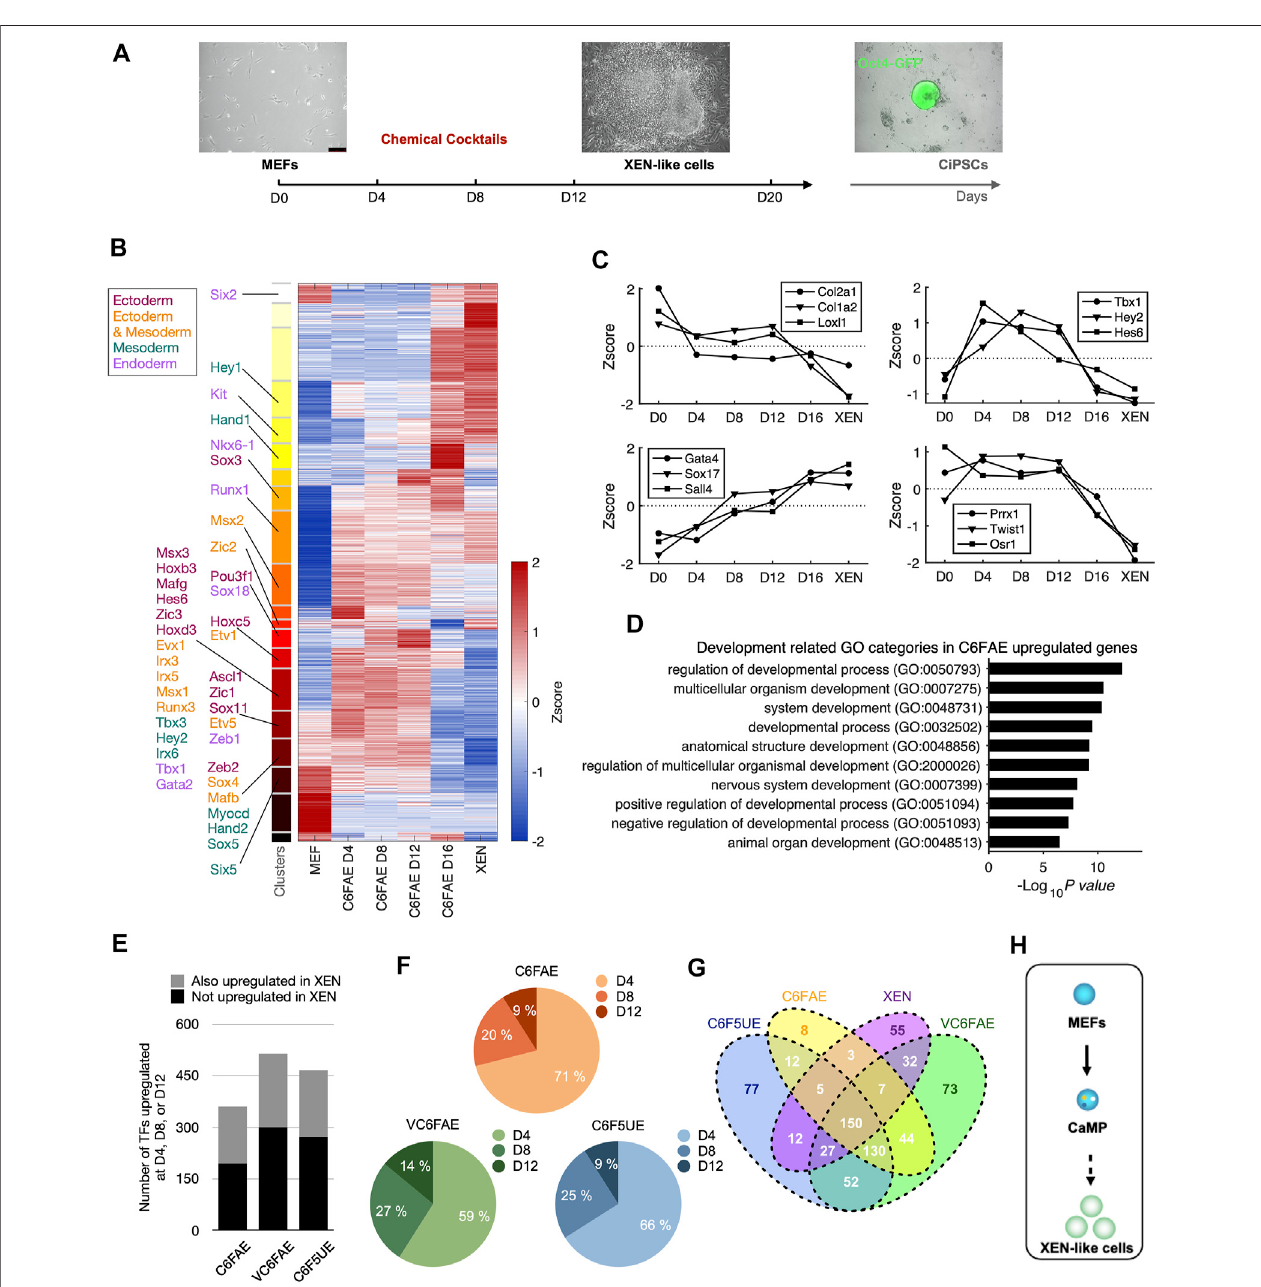
FIGURE 1 | Chemical cocktails activate the endogenous expression of transcription factors for multiple lineages. (A) Schematic diagram of chemical reprogramming and bulk RNA-Seq sampling. (B) Clustering of temporal gene expression dynamics in the early stage of chemical reprogramming. K -means clustering partitioned geneswhich FPKM > 1 at least one-time point into 20clusters. Known transcription factors (TFs) governing three germ layers development arelabeledto the corresponding clusters. (C) Representative gene expression dynamics during the early stage of chemical reprogramming. Left top: continuous decline; right top: increase and decline; left bottom: continuous increase; right bottom: late decline. (D) Chemical cocktail, C6FAE, upregulated genes in development-associated GO categories.Geneontologyanalysiswasperformedwithgenesthatexpressedatleast1.5largerthanMEFinnormalizedmeasurement(log 2 (FPKM+1))atday4,day8,or day 12. (E) Number of upregulated TFs with different chemical cocktail treatments. Height of bars: total numbers; grey: TFs upregulated in the fi rst 12 days and in XEN celltype;black:TFsupregulated inthe fi rst12 daysbutnotinXENcelltype. (F) Percentagesofupregulated TFsatdifferenttimepointswithdifferentcocktailtreatments. TFs were alignedtothe time points based on the fi rst time they show1.5 larger than MEF innormalized expression. (G) Venn diagram ofupregulatedTFs within different cocktail treatments (day 4, 8, or 12) and XEN cells compared with MEF. (H) Two steps schematic highlighting CaMP state in the early stage of XEN induction.